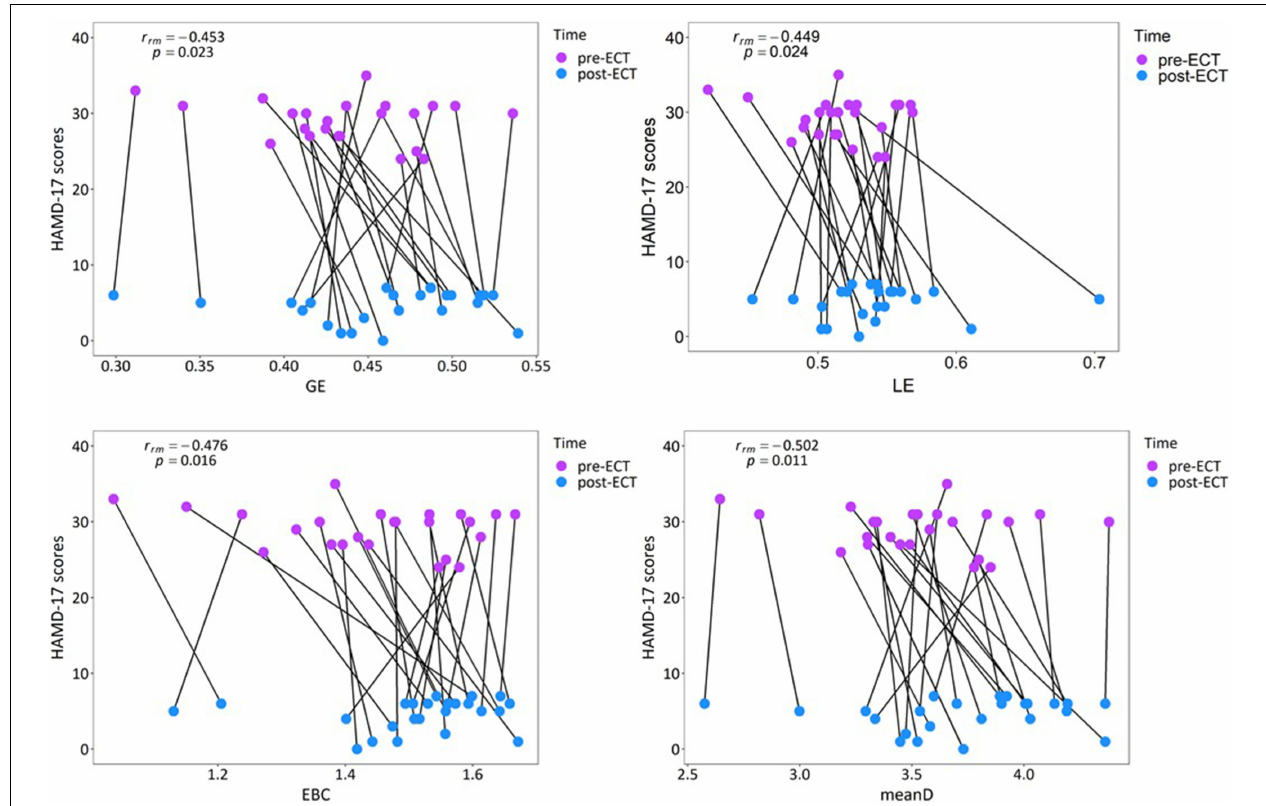
FIGURE 7 | Relationship between the network metrics and the clinical response in individual patients with MDD in the alpha band.